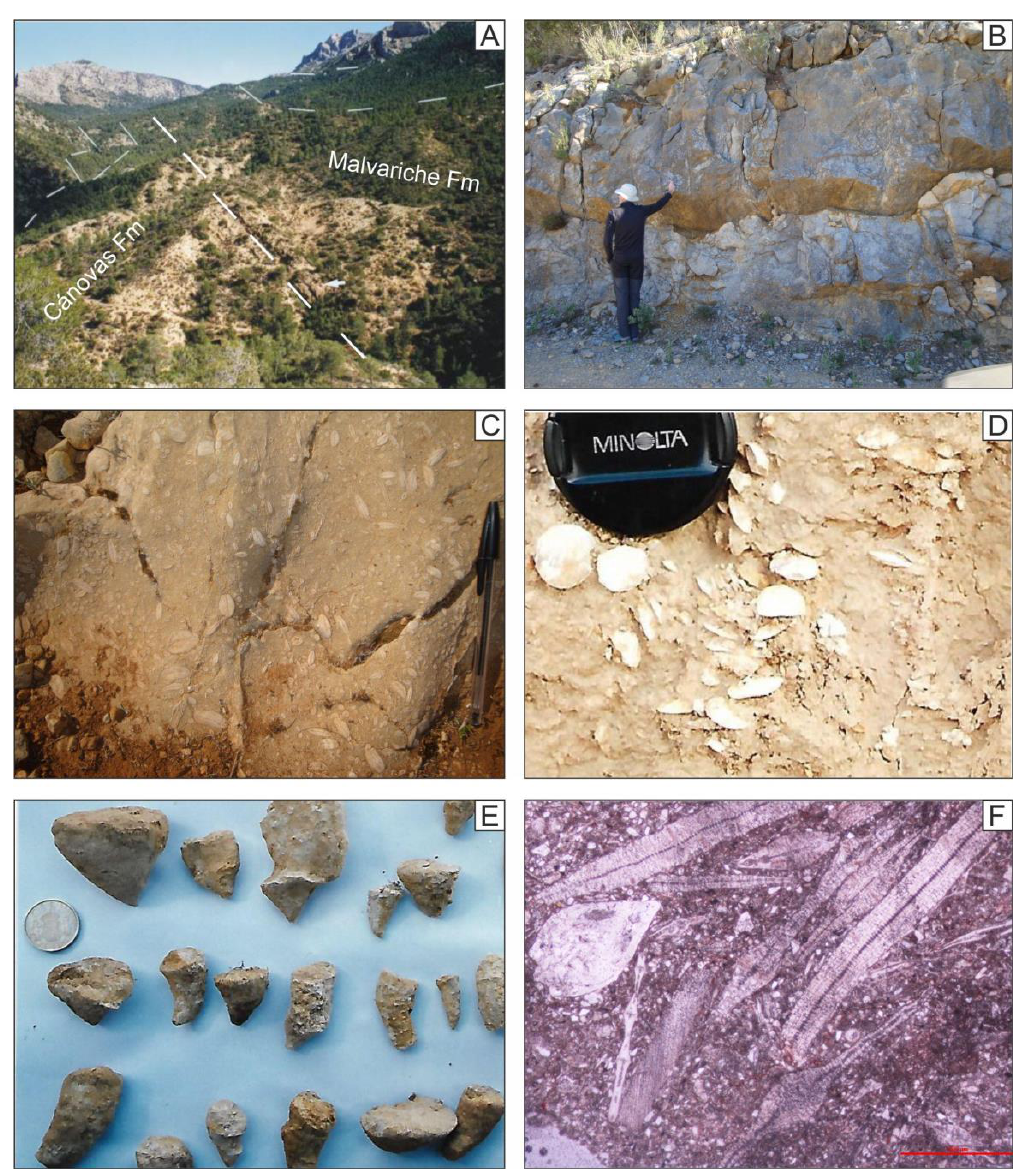
Figure 8. Site 4: The Middle Eocene Malvariche and Cánovas fms in the Malvariche Valley. ( A ) Panoramic View of the Malvariche Valley. ( B ) Field outcrop of the Malvariche Fm. ( C ) Detail of the fossils from the Malvariche Fm. ( D ) Field outcrop of the C á novas Fm with flat larger foraminifera. ( E ) Solitary corals collected in the C á novas Fm. ( F ) Thin section of the C á novas Fm: flat larger